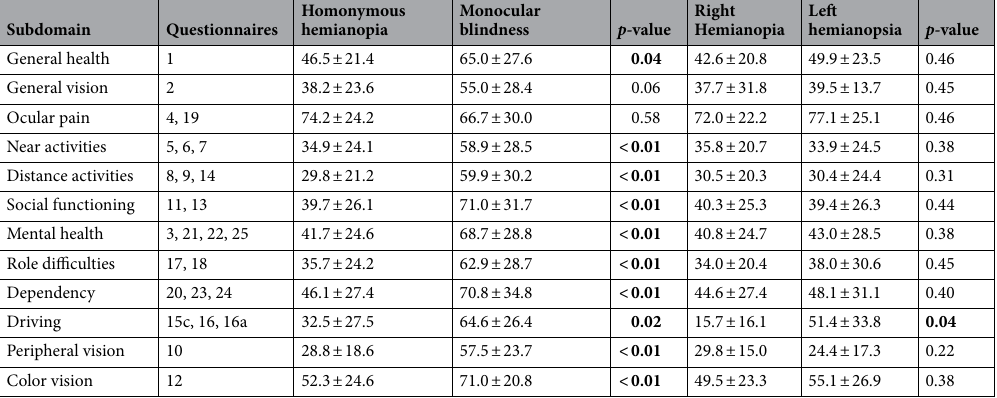
Table 2. Analysis of National Eye Institute-Visual Function Questionnaire (NEI-VFQ) between homonynous hemianopia and monocular blindness group.